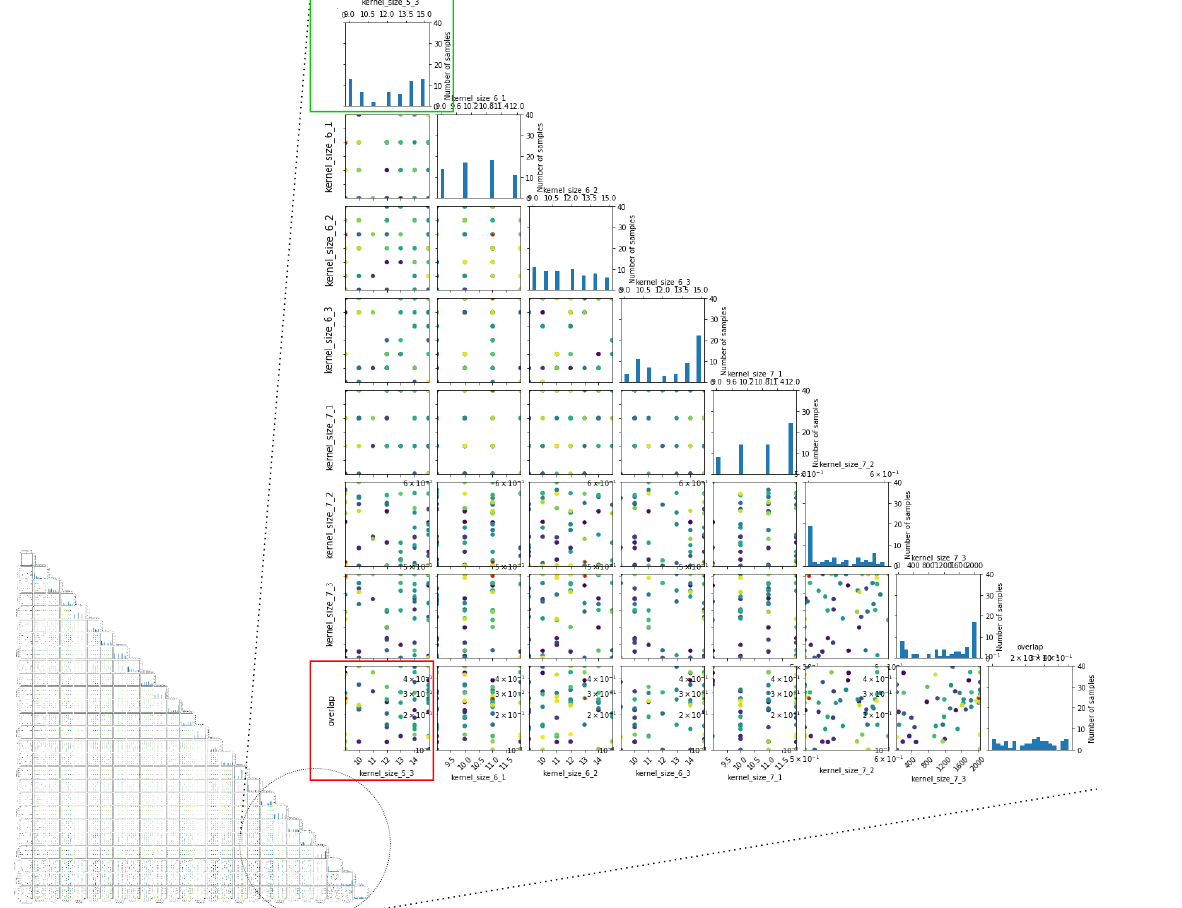
Figure 20. Summary of the hyperparameters instantiations (or realizations) that have been evaluated during the construction of the surrogate model. For example, the highlighted plot (red box) shows the joint instantiations of the hyperparameter overlap (or stride) ( s ) and the kernel size ( ks 5 ). The realizations are illustrated with graduated colors representing the quantity of interest (recognition performance) of the model at this location of the space. The figure zooms on the rightmost part of the diagram for better readability. The plots on the diagonal show the distribution of the realizations for each individual hyperparameter. For example, the highlighted plot (green box) describes the distribution of the instantiations in the case of kernel size ( ks 5